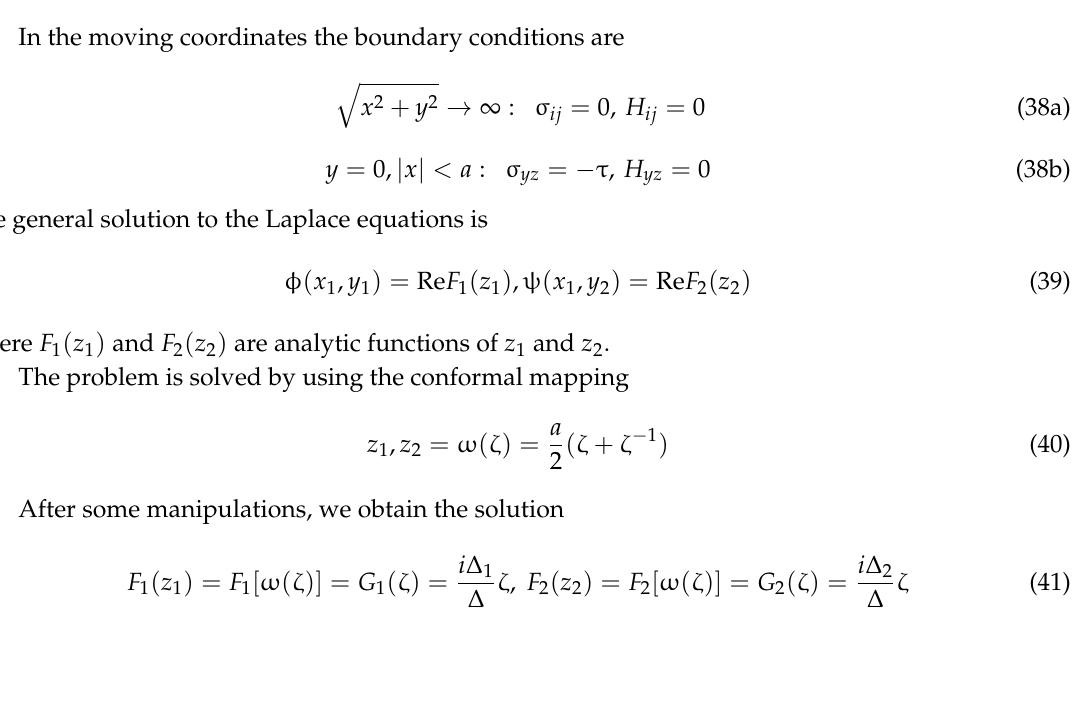
Figure 1. Moving Griffith crack of Mode III.